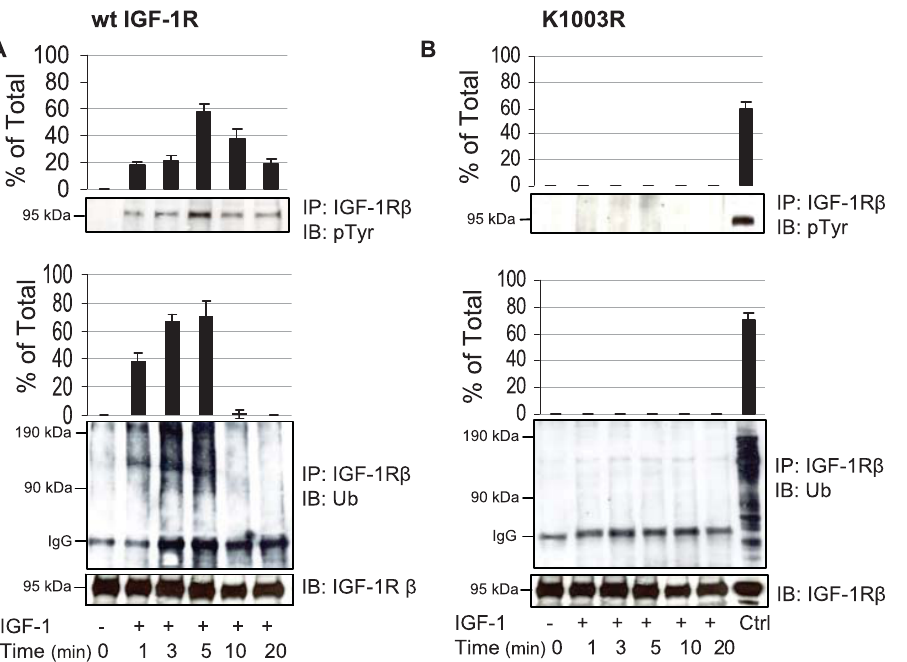
Figure 2. Ubiquitination of IGF-1R is phosphorylation dependent. After 24-h serum starvation wt IGF-1R (A) and K1003R (B) cells were stimulated for indicated time points with 50 ng/ml IGF-1. Lysates were immunoprecipitated (IP) with anti-IGF-1Rß (H60), and blotted with either anti- phosphotyrosine (pY99) or anti-ubiquitin (p4D1). The graphs represent quantification (% of loading control) of three independent experiments. Means and SDs are shown. Equal loading was confirmed by stripping and re-immunoblotting with anti-IGF-1Rß (C20).